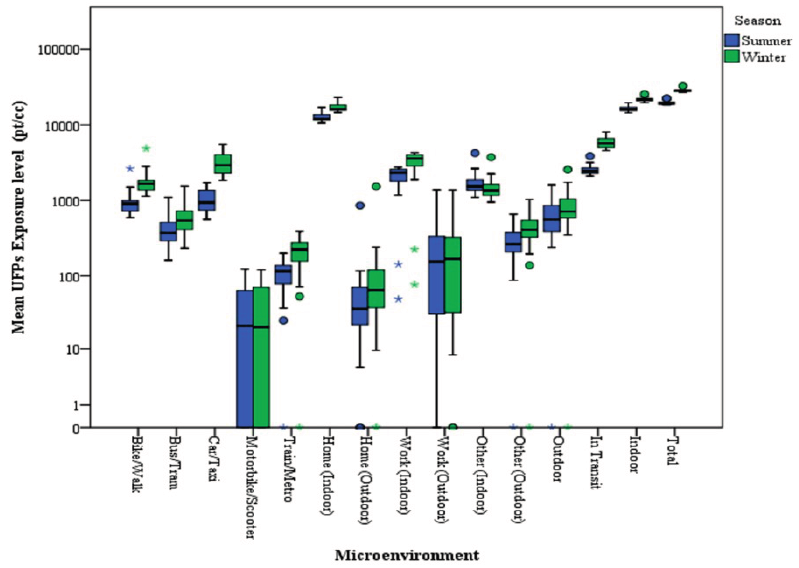
Figure 2. Box plots of calculated UFP exposures (pt/cm 3 ) estimated in indoor and outdoor microenvironments for summer and winter. The central box comprises values between the 25th and 75th percentiles, and the whiskers show the range of values that falls within 1.5 times the interquartile range beyond the